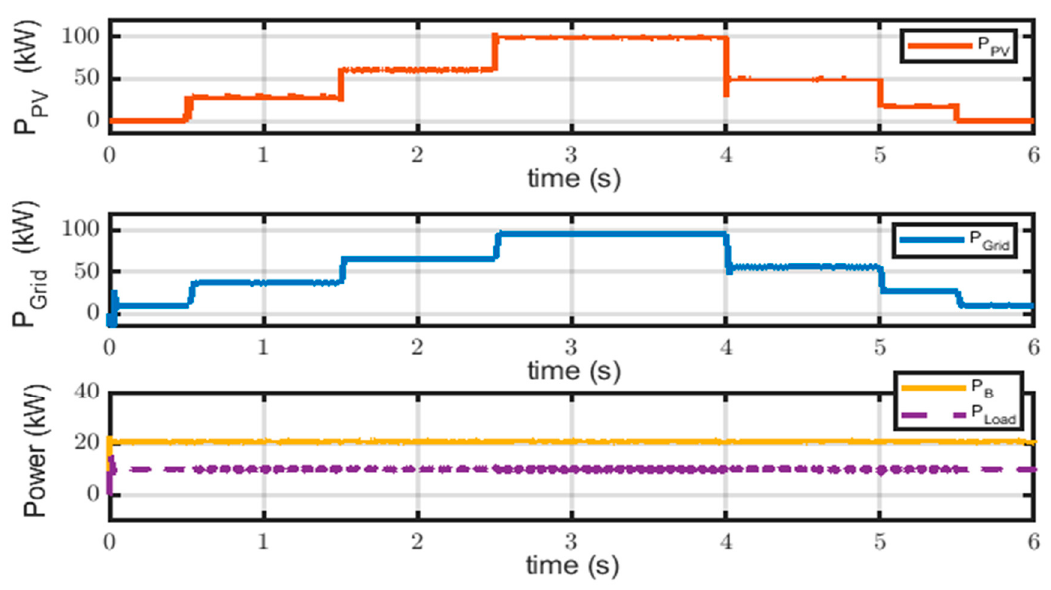
Figure 11. Power flow in grid-tied PV microgrid with constant battery discharge.